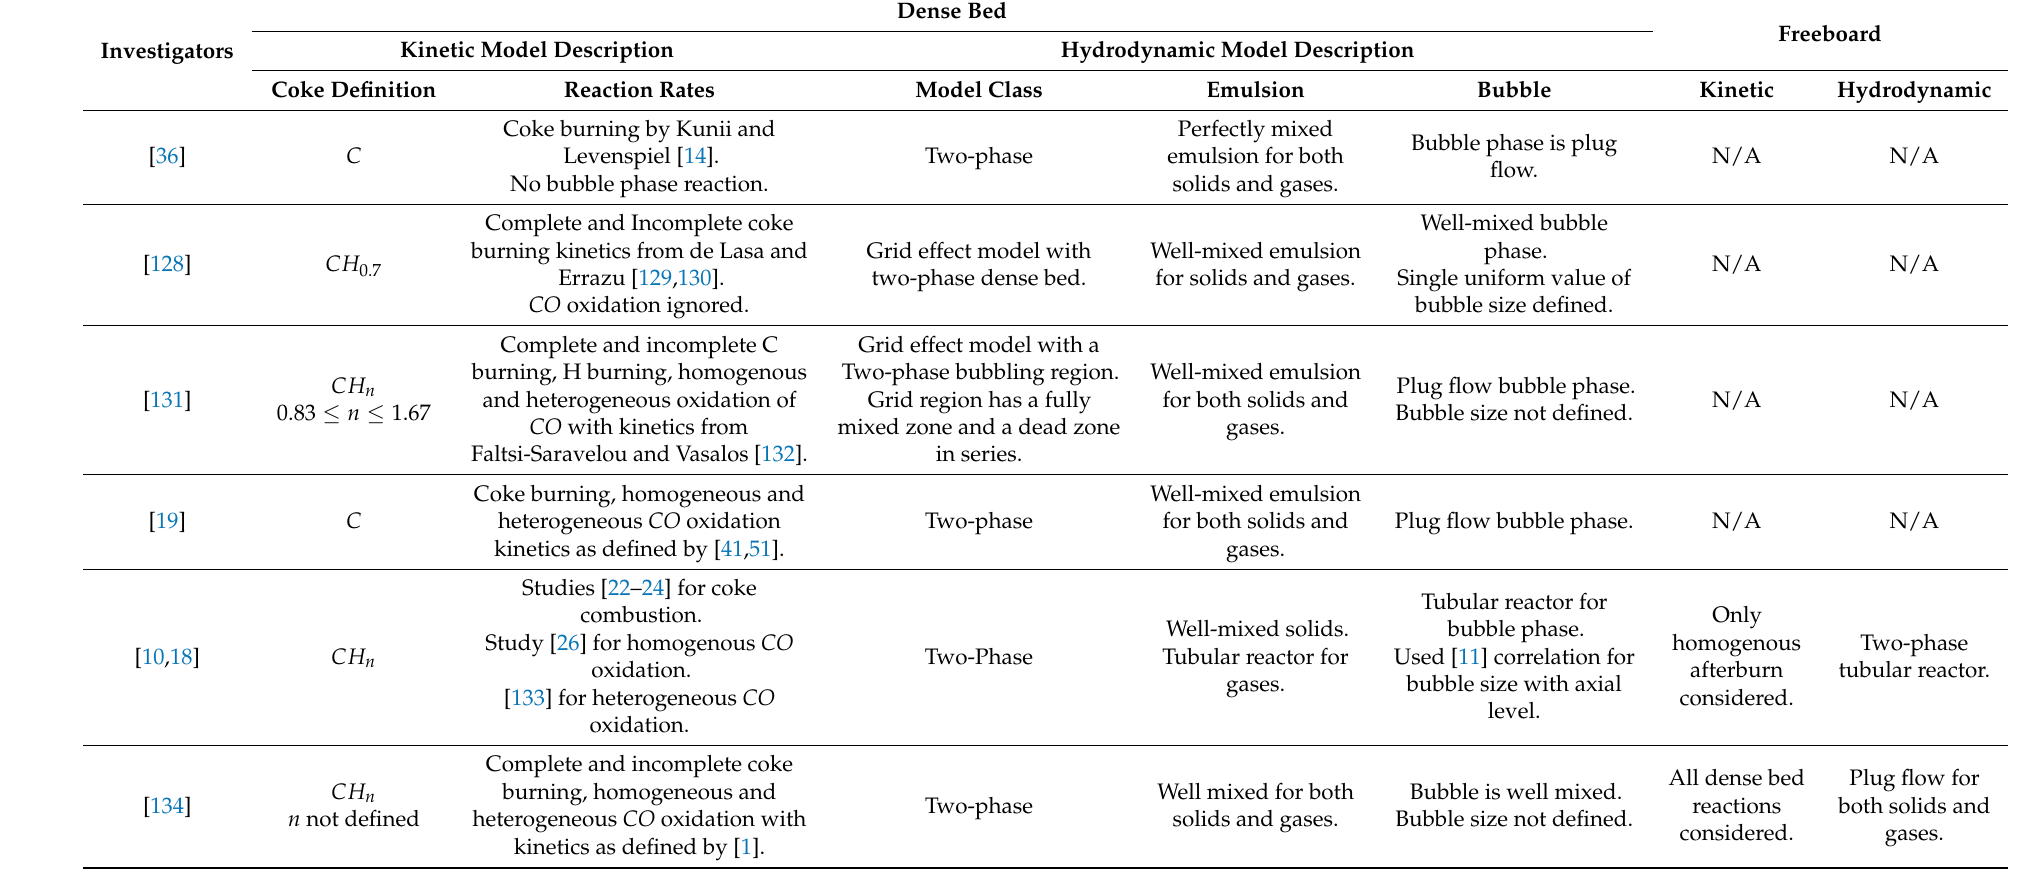
Table 4. Review of FCC Regenerator